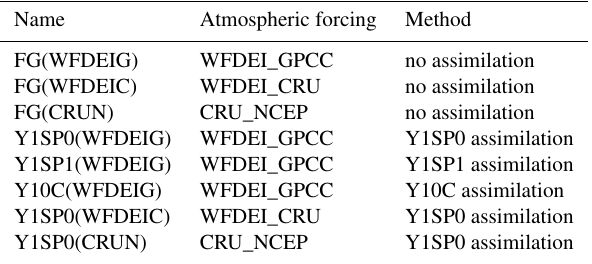
Table 1. The assimilation and simulation